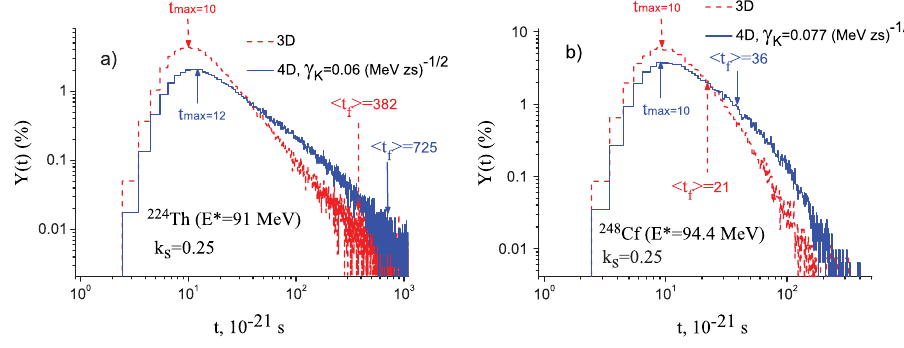
Figure 1. The fission time distribution for the 224 Th (a) and 248 Cf (b) fissioning nuclei in 3D (dashed histogram) and 4D (solid histogram) calculations obtained with k s =0.25 and different (cid:1) K